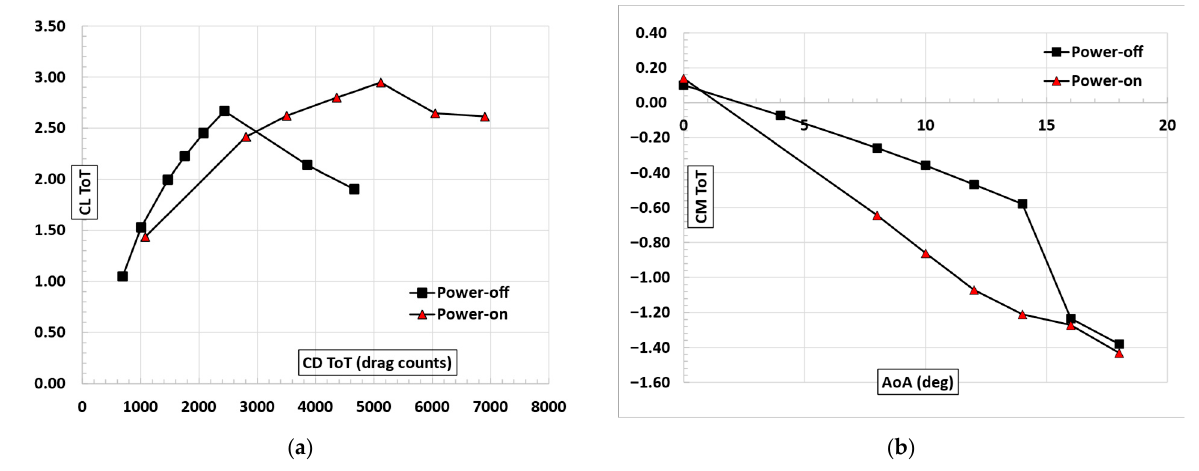
Figure 21. Total lift coefficient curves for power-off and power-on take-off conditions, M = 0.15, Re